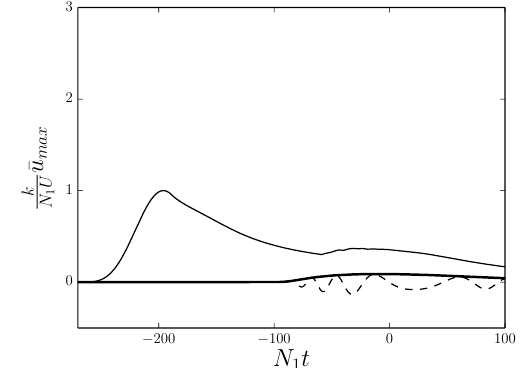
Figure 17. Time history of the maximum of the mean flow. The dashed line is the velocity jump at the interface while the thick solid line that is the maximum the interference mean u i . The parameter =√ values are n 1 /k 2, N 2 /N 1 = 2, (cid:15) = 0.025, and α =